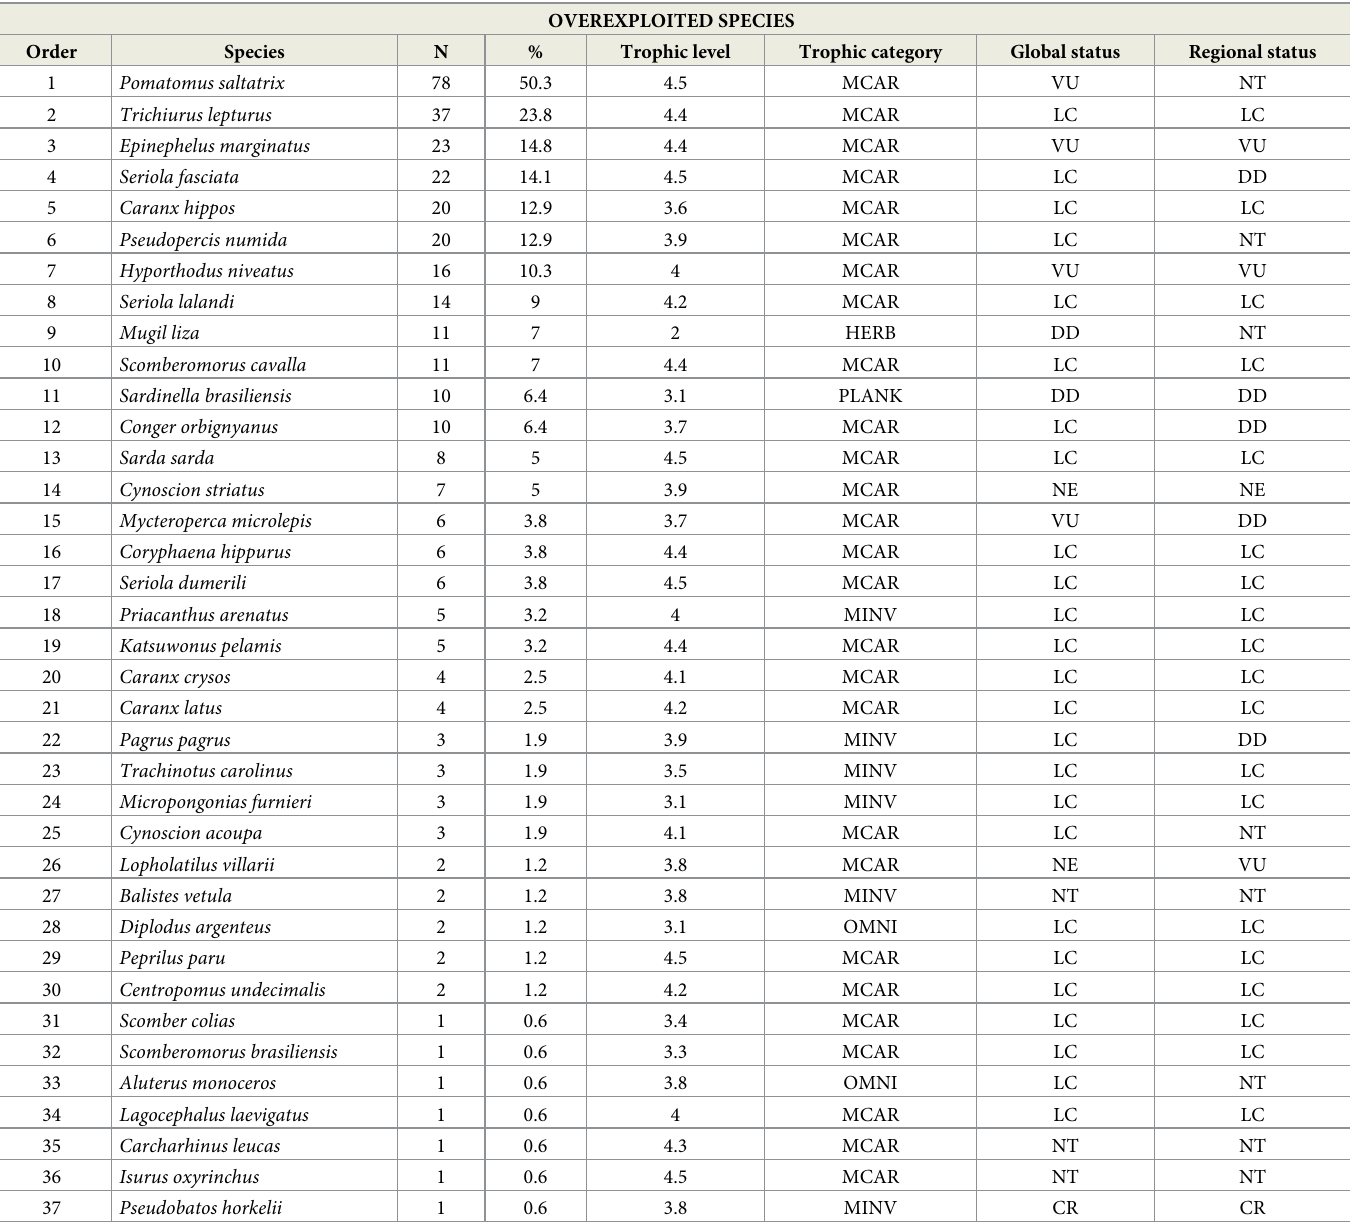
Table 1. Species reported as overexploited by fishers in descending order of number of citations (N).